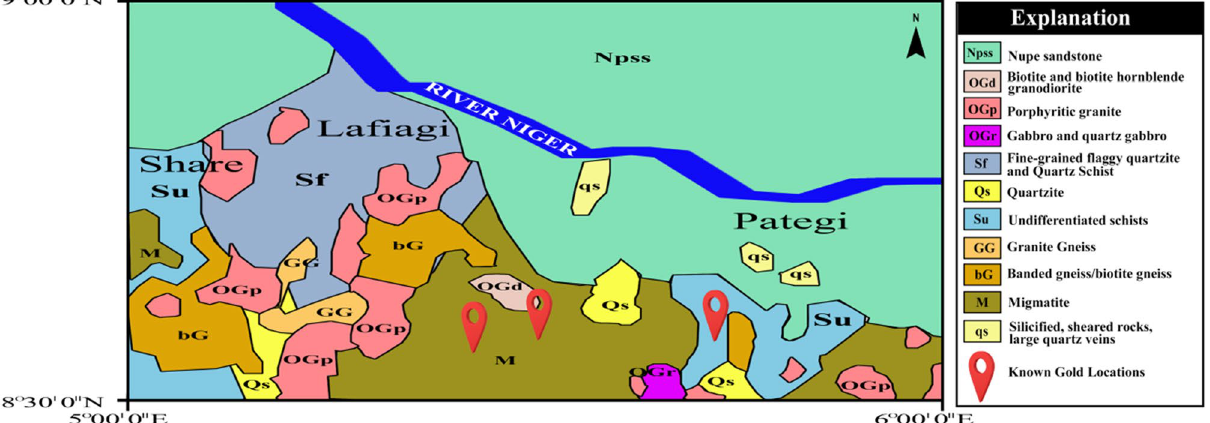
Figure 2. Simplified geological map of Lafiagi and Pategi regions 24 . Known gold locations adopted from Ref. 25 . The figure was produced using Adobe Photoshop CS5 Software version 12.0 (Website: https:// www. adobe. com/ produ cts/ photo shop.